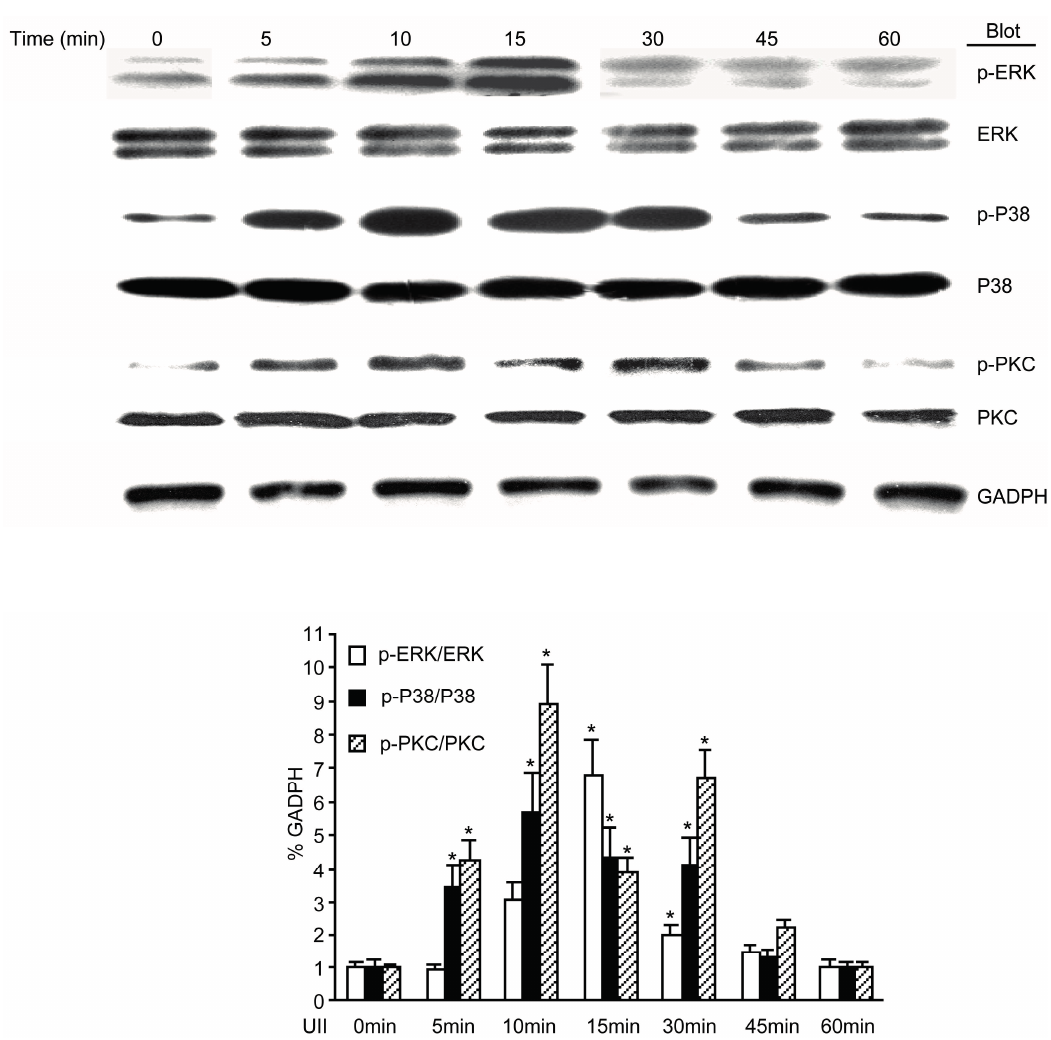
Figure 5. UII induced the phosphorylation of PKC, ERK, and p38 MAPK in BEL-7402 cells. BEL-7402 cells were treated with 100 nmol/L UII for various periods of time, and the phosphorylation of PKC, ERK, and p38 MAPK were detected by western blot analysis. Data are mean ± SE ( n = 5, * p < 0.05 compared with